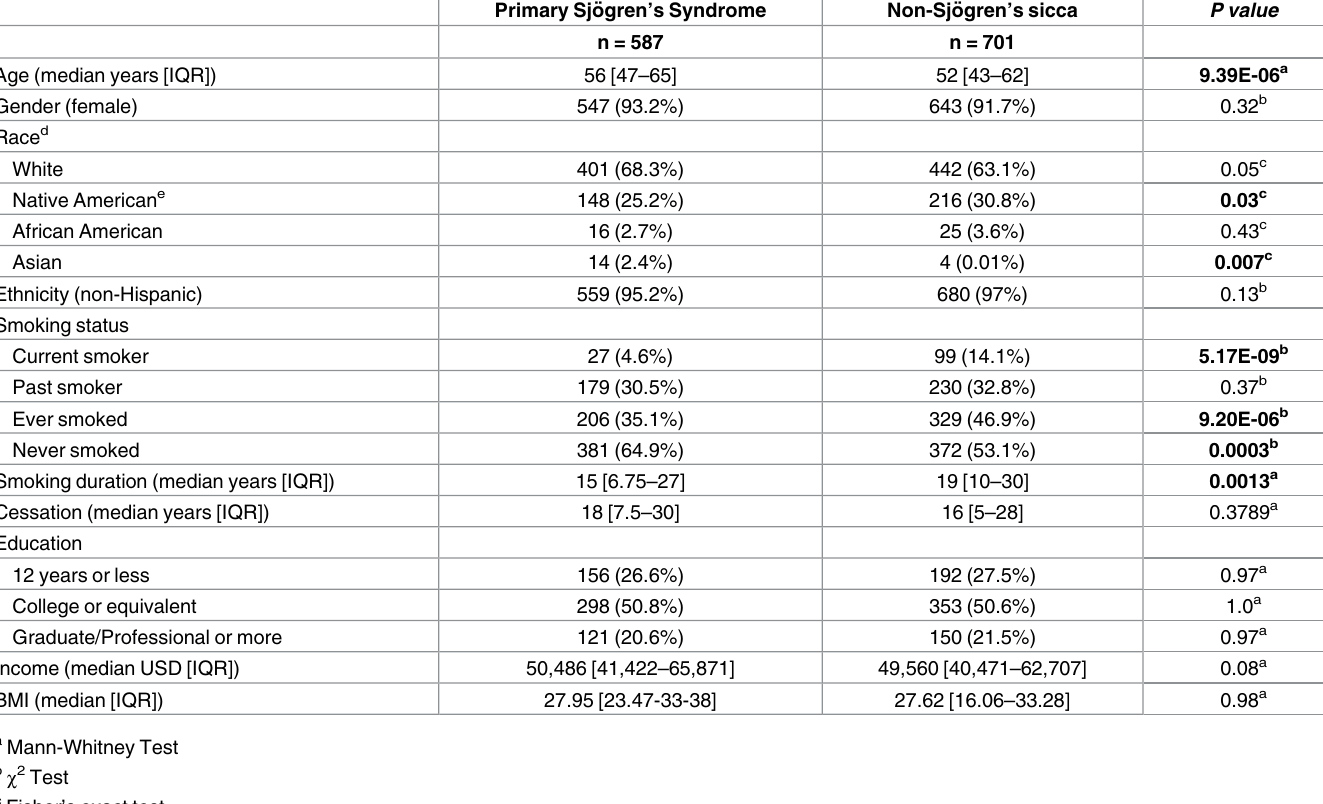
Table 1. Sociodemographic characteristics and smoking status of study participants with primary Sjo¨gren’s syndrome and non-Sjo¨gren’s